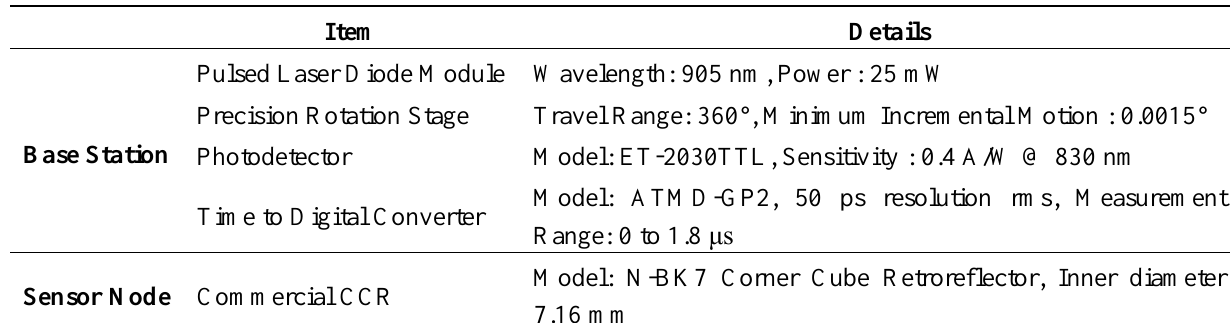
Table 1. Specifications of the